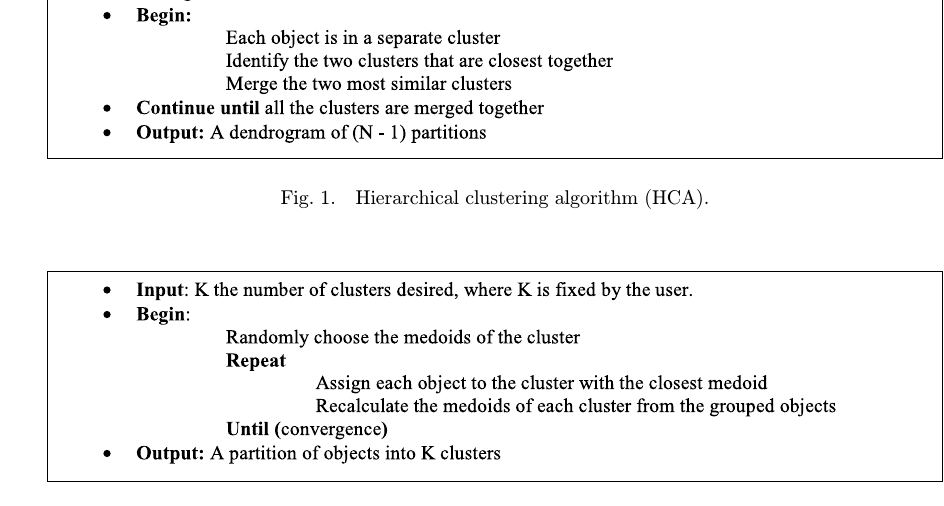
Fig. 2. K -medoids algorithm.